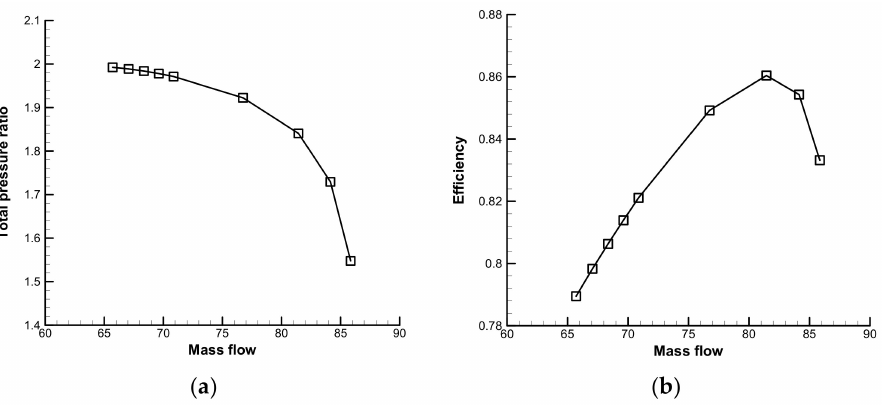
Figure 14. Steady-state characteristics of a single-rotor fan ( a ) total pressure ratio characteristic, ( b ) efficiency